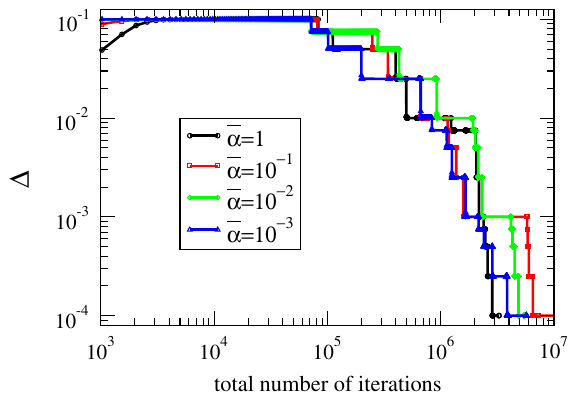
FIG. 8. Dimensionless pressure Δ as a function of iteration number for a packing-generating simulation starting from one particular initial condition. Each step of the staircase shape of the signal corresponds to the production of a packing at some desired target pressure. The criterion for convergence to mechanical equilibrium at each pressure is explained in the text. We produced packings ranging from Δ ¼ 10 − 1 to Δ ¼ 10 − 5